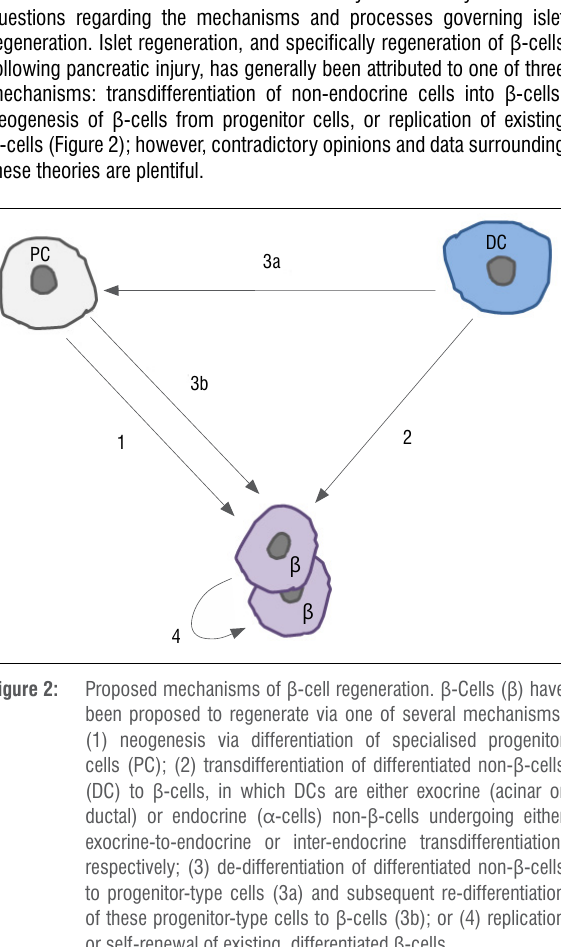
Brief overview of the regulation of in-utero β -cell development by transcription factors during pancreatic organogenesis.